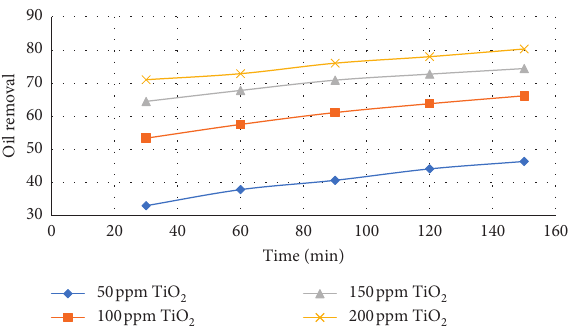
2 (150ppm) and irradiation time (120min).